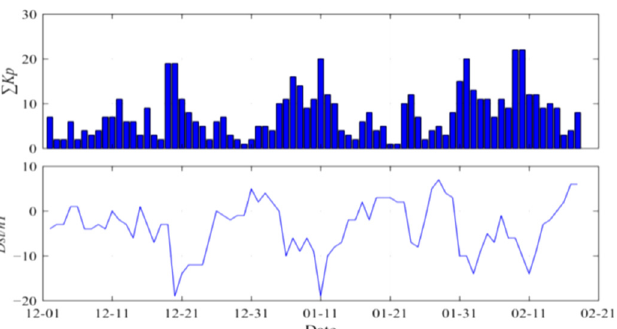
Figure 11. Changes in the ∑ Kp and Dst indices during the selected study period of the sample earth- quake